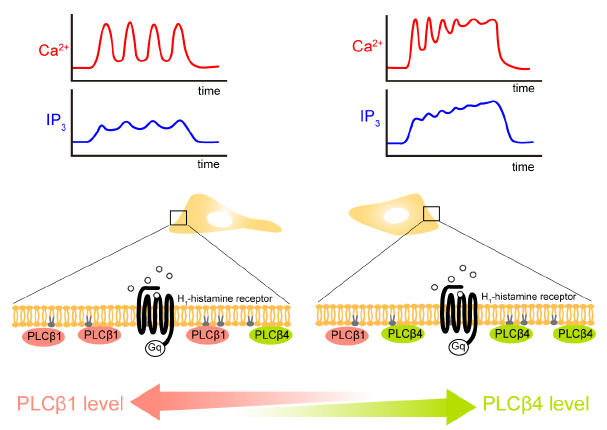
Figure 7. A possible mechanism that underlies the generation of cell-specific patterns of histamine-induced Ca 2 + signals. The diagrams show the typical IP 3 and Ca 2 + dynamics observed in HeLa cells stimulated with histamine. Low-frequency sustained Ca 2 + oscillations tend to be observed in cells in which PLC- b 1 is dominant (left), while high-frequency damped oscillations tend to be observed in cells in which PLC- b 4 is dominant (right).